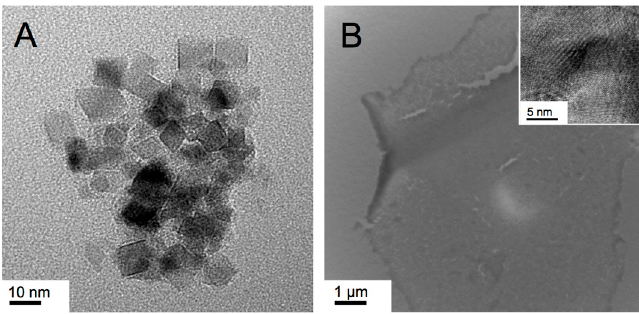
Figure 1. Transmission electron microscopy (TEM) images of previously synthesized IO nanostructures: ( A ) polyhedral nanobricks prepared by co-precipitation of Fe(III)- and Fe(II)-precursors (2:1 ratio) in the LLC phases (lamellar and hexagonal columnar) of Triton X-100 or Triton X-45 in H 2 O [46]. Using TEM tomography the height of the nanobricks was determined to be ~5 nm. Reproduced from Ref. [46] with permission from The Royal Society of Chemistry; ( B ) Large nanosheets (lateral dimensions up to several micron) prepared in the Col h LLC phase formed by Triton X-100 in water using the reduction/hydrolysis method feature heights of 5 or 10 nm (inset shows higher resolution) [47]. Reproduced from Ref. [47] with permission from The Royal Society of Chemistry.